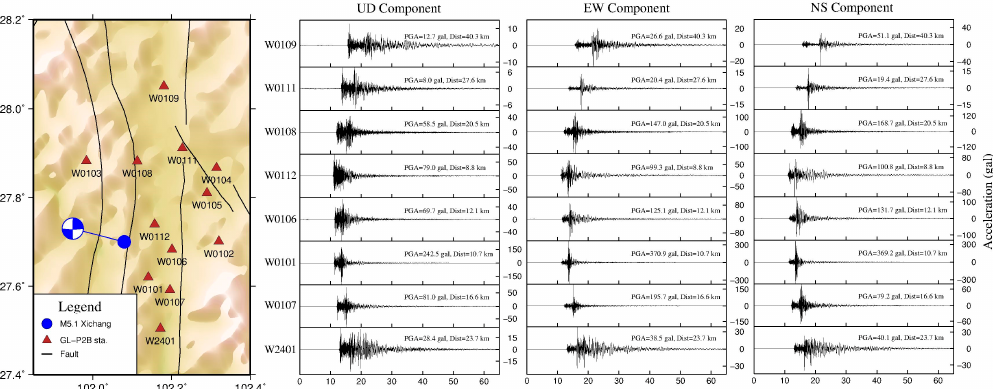
Figure 8. A series of acceleration waveforms recorded by GL-P2B sensor network during the 31 October 2018, M 5.1 Xichang earthquake. These plots show the data quality of the network for up–down (UD), east–west (EW), and north–south (NS) components.